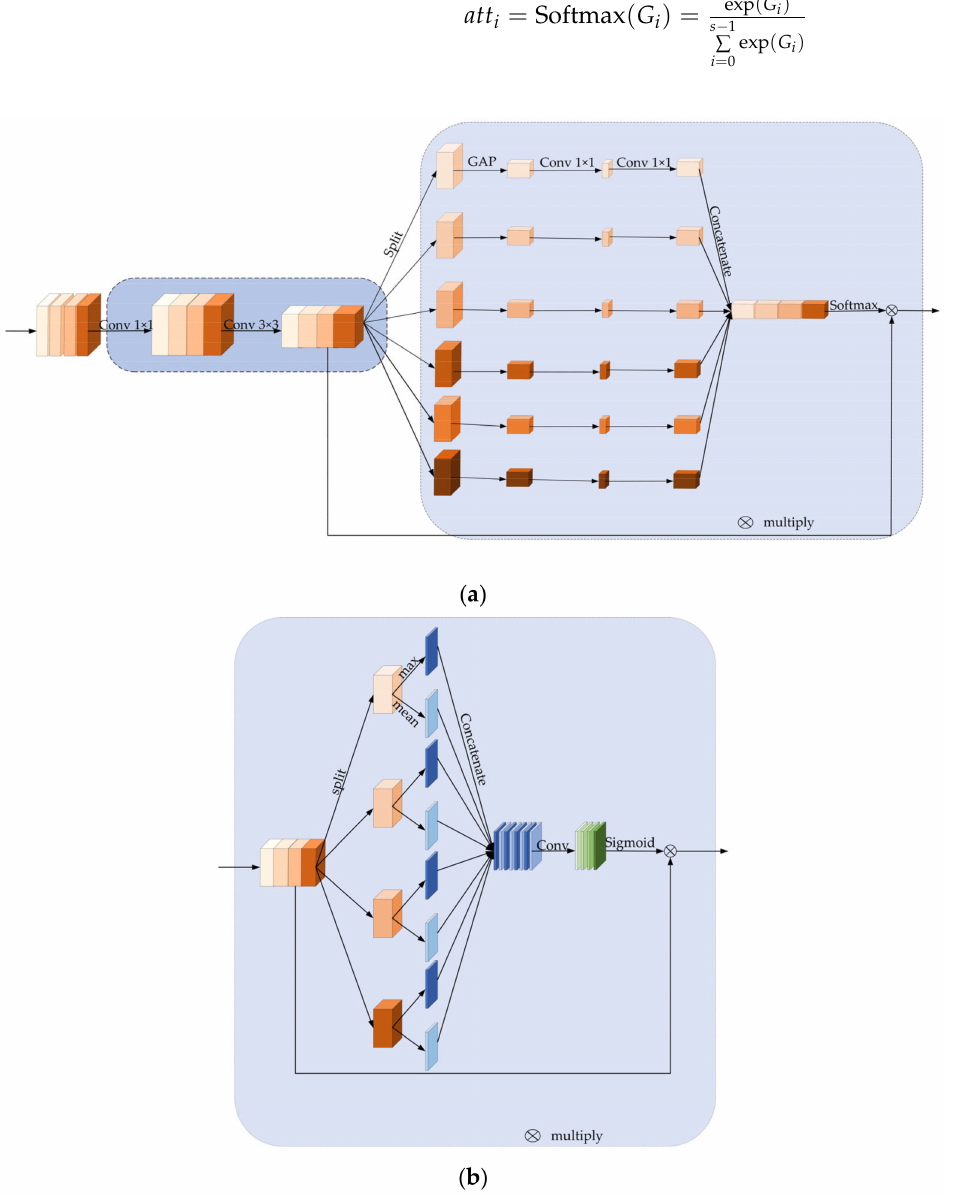
Figure 6. ( a ) Multi-scale attention mechanism (channel). ( b ) Multi-scale attention mechanism